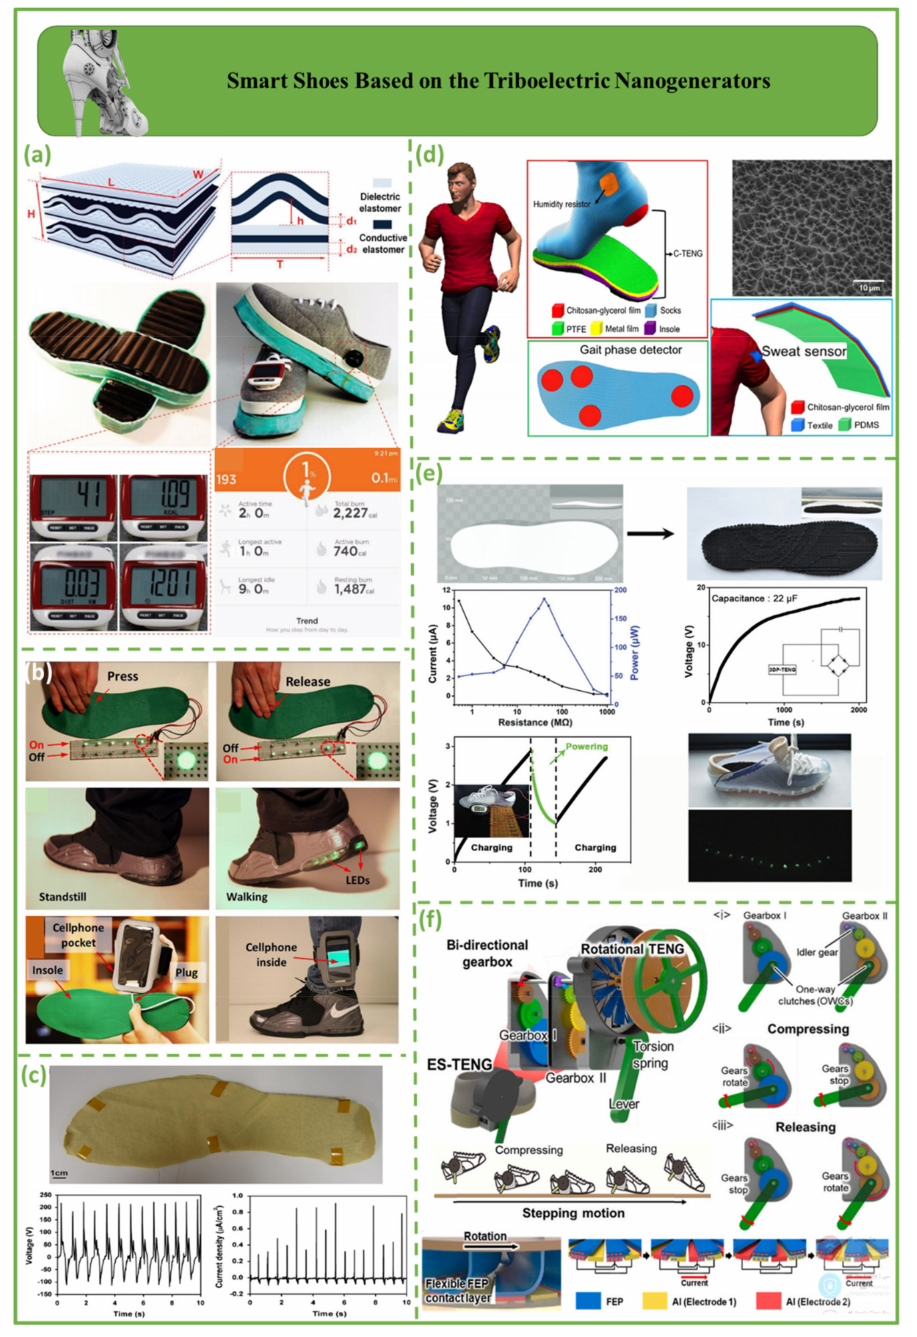
Figure 7. Demonstration of smart shoes based on triboelectric nanogenerators. ( a ) Multilayer elastomeric triboelectric nanogenerators as shoe outsoles [94]. ( b ) Self-lighting shoe with LEDs in the air cushion [95]. ( c ) A TENG − based shoe insole harvests human walking energy to light 30 white LEDs in series [96]. ( d ) Self-powered gait phase detector with four integrated C − TENGs [97]. ( e ) Principle and functionality of 3DP − TENG [98]. ( f ) Schematic illustration of ES − TENG, which consists of a bidirectional gearbox and a rotational TENG